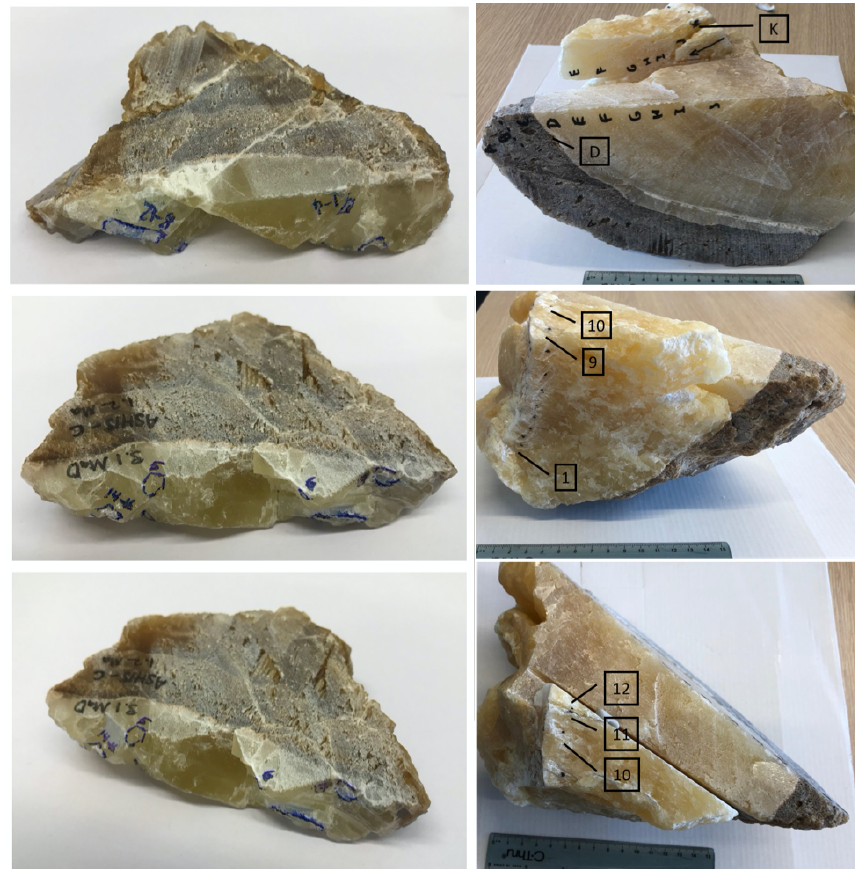
Figure A1. Photographs of ASH15 flowstone with top images showing layers D (light) and A–C (brown) and bottom images showing layers K to D. Sampling localities of aliquots sampled for ID-TIMS analyses are indicated by numbers matching the aliquots in the data Table S6. Larger pieces were chipped off using a stainless-steel needle and subdivided into smaller aliquots for